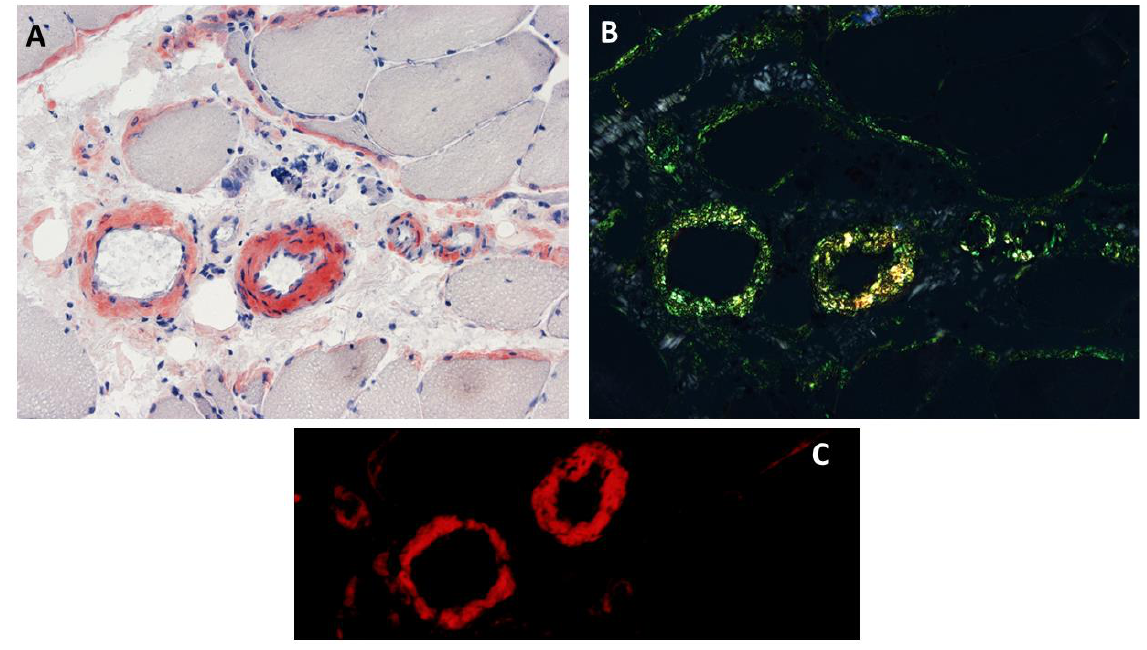
Figure 3. Histopathological findings in ANO5 muscle diseases. Congophilic deposits in intramuscular blood vessels and perimysium adjacent to perifascicular fibers are observed on Congo red stained section viewed under bright light ( A ), polarized light, ( B ) and rhodamine optics ( C ). A Western blot study using monoclonal antibody clone N421A/85 (UC Davis/NIH NeuroMab, Davis, CA, USA) was able to show a reduction in ANO5 expression in muscle lysates obtained from selected patients with ANO5 muscle diseases [58]. The